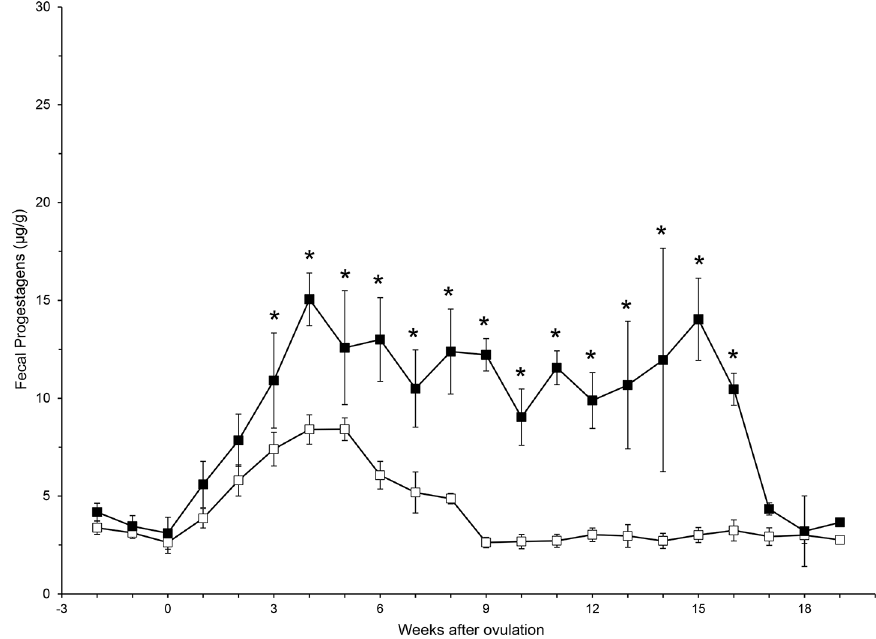
Fig 3. Weekly average ( ± SE) fecal progestagen metabolite concentration for pregnant (filled squares) and non-pregnant (open squares) luteal phases. Post-hoc Bonferroni correction analysis for significance between PLP and NPLP weekly average FPM concentrations are denoted by asterisks.